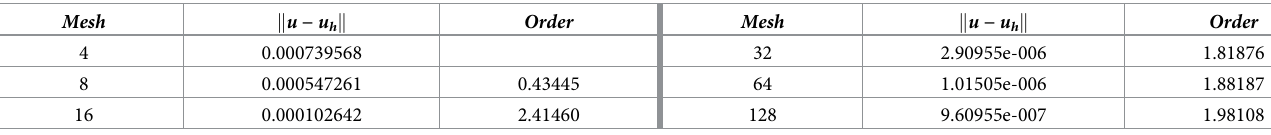
Table 4. Error profile and convergence rate for the Experiment 4.